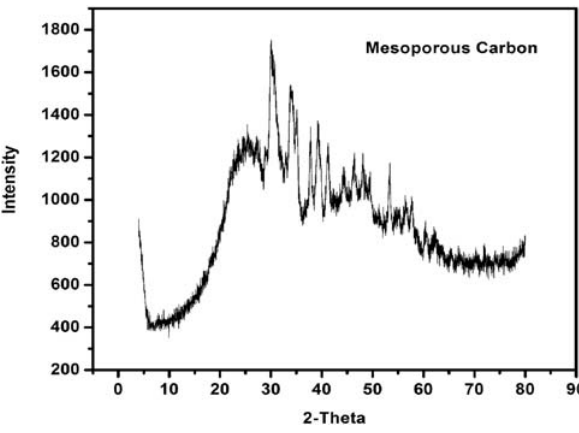
Figure 2: XRD patterns for mesoporous carbon.